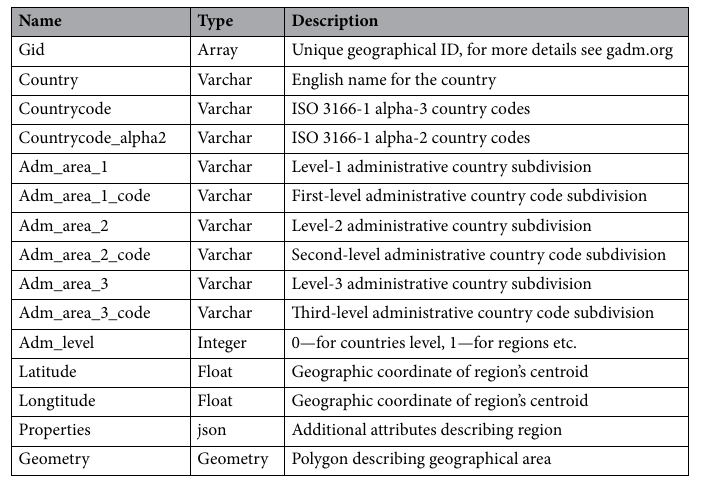
Table 1. Schema for ADMINISTRATIVE_DIVISIONS table.